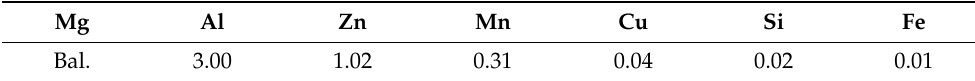
Table 1. Chemical composition of AZ31 alloy in wt.